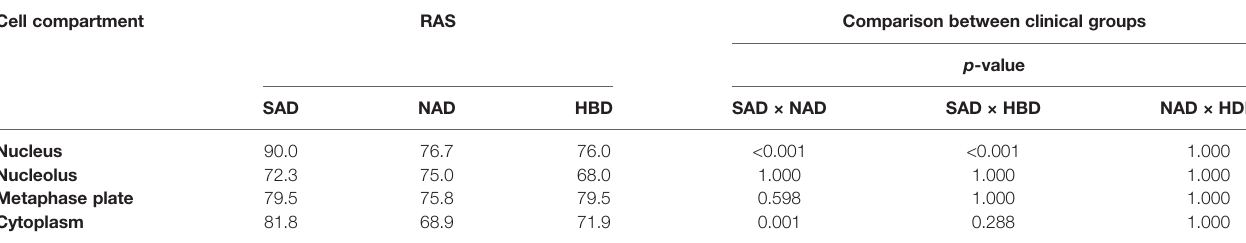
TABLE 2 | Reactivity agreement score (RAS) in each cell compartment according to the clinical group. Cell compartment RAS Comparison between clinical groups